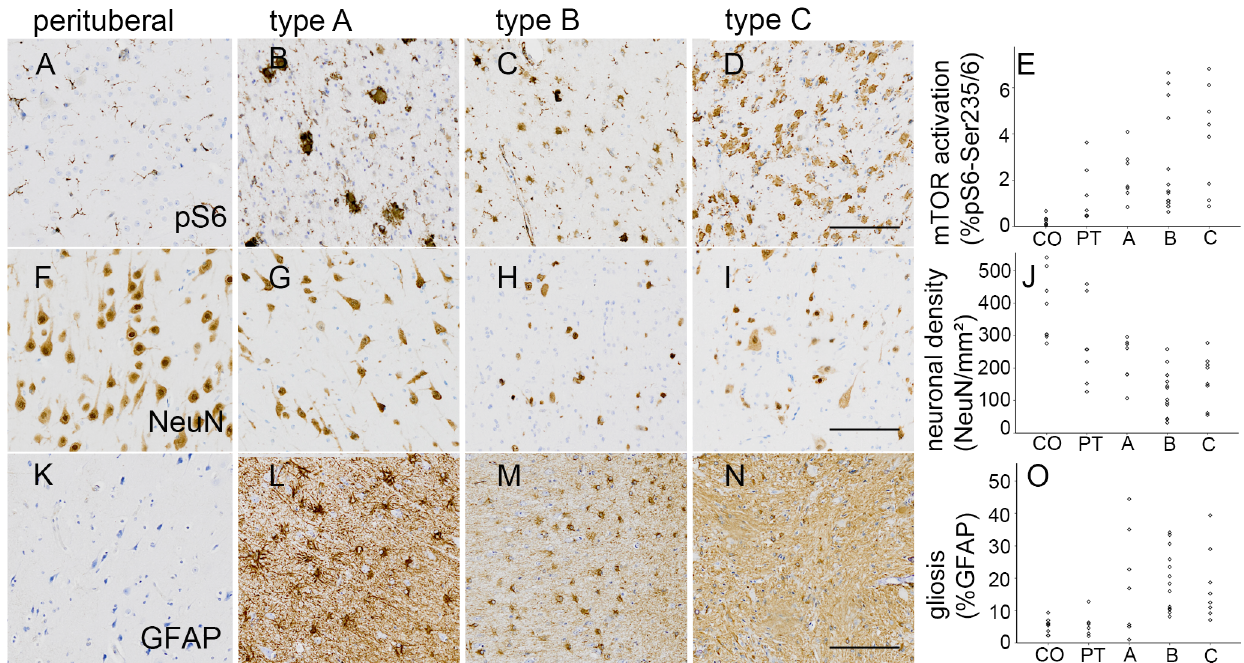
Fig 2. mTORC1 activation, neuronal quantity and gliosis. A. — D. mTOR activation was present in all cortical tuber types as well as in perituberal cortex (pS6-Ser235/236 staining). E. Gradient mTOR activation among the tuber types. F. — I. Loss in neuronal cell density could be observed in type B tubers (NeuN staining). J. Neurons were significantly depleted ( p = 0 . 015 ). K. — N. Gliosis was present in all tuber types (GFAP staining). O. Increase of gliosis reached significance ( p = 0 . 019 ). Scale bar in D , I , and N = 100 μ m and applies also to F , G , H , K , L , and M . CO = control; PT = perituberal cortex